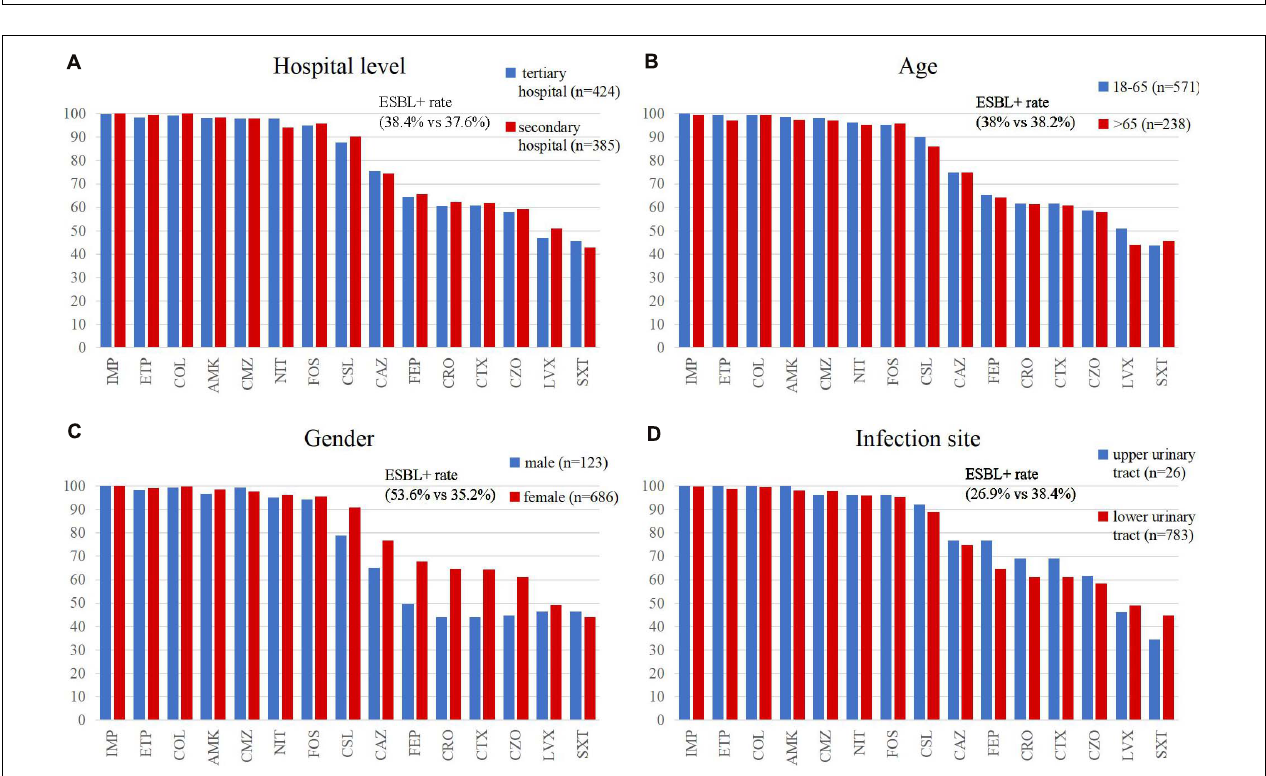
FIGURE 4 | Susceptibility rates of CA-UTI Escherichia coli strains with different ESBL phenotypes. IMP, imipenem; ETP, ertapenem; COL, colistin; AMK, amikacin; CMZ, cefmetazole; NIT, nitrofurantoin; FOS, fosfomycin; CSL, cefoperazone/sulbactam; CAZ, ceftazidime; FEP, cefepime; CRO, ceftriaxone; CTX, cefotaxime; CZO, cefazolin; LVX, levofloxacin; and SXT, trimethoprim/sulfamethoxazole.